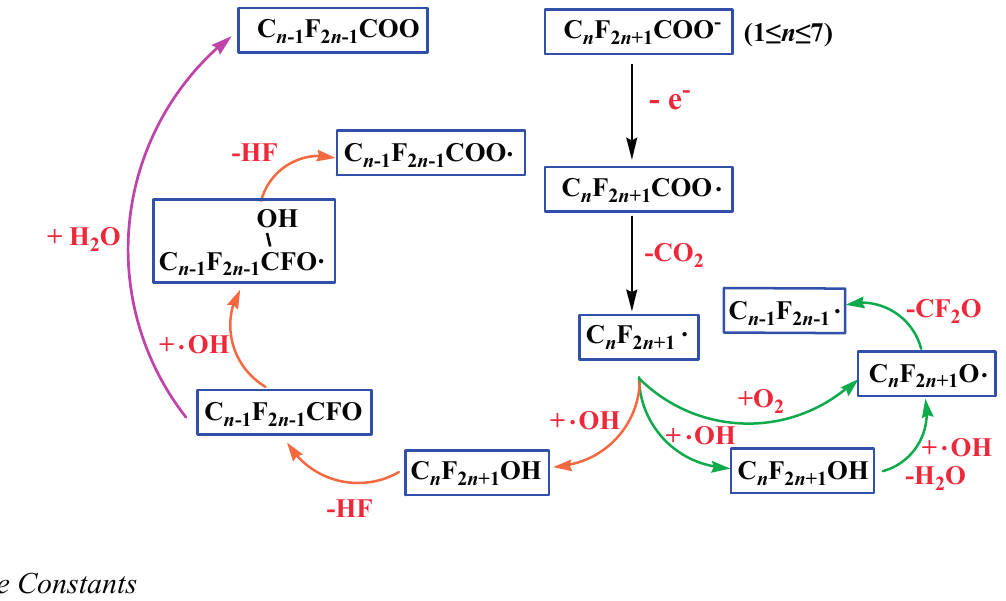
Figure 2. The three reaction circles in the electrochemical degradation pathways.